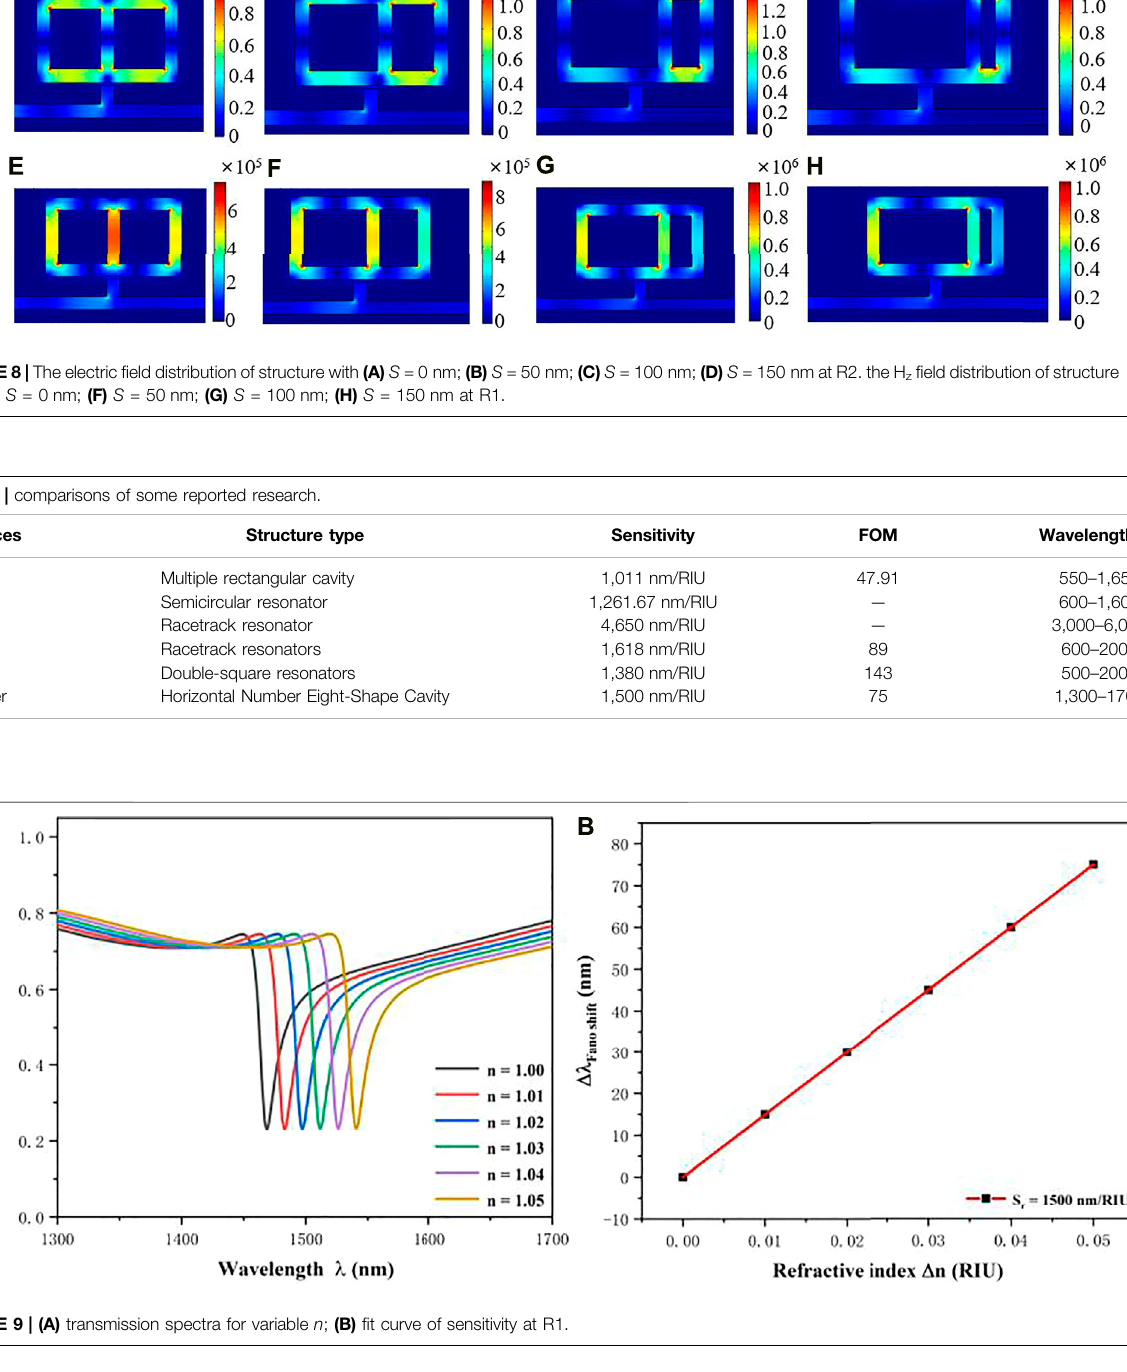
Frontiers in Physics |